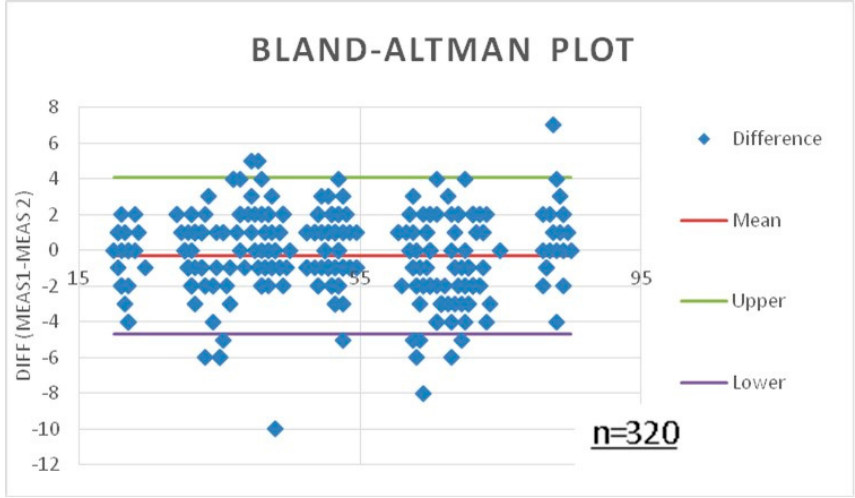
Figure 9. Bland–Altman Plot about the agreement of ISQ measurement for each sample. The mean difference was estimated bias, and the SD of the differences measured the random fluctuations around this mean.